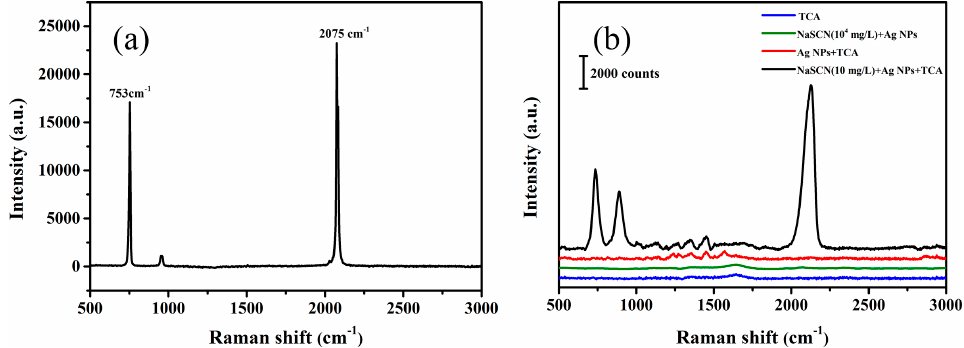
Figure 2. The Raman spectra of the samples. ( a ) NaSCN solid powders. ( b ) TCA, a mixed solution of TCA and Ag NPs, a mixed solution of NaSCN and Ag NPs, a mixed solution of NaSCN, TCA and Ag NPs.